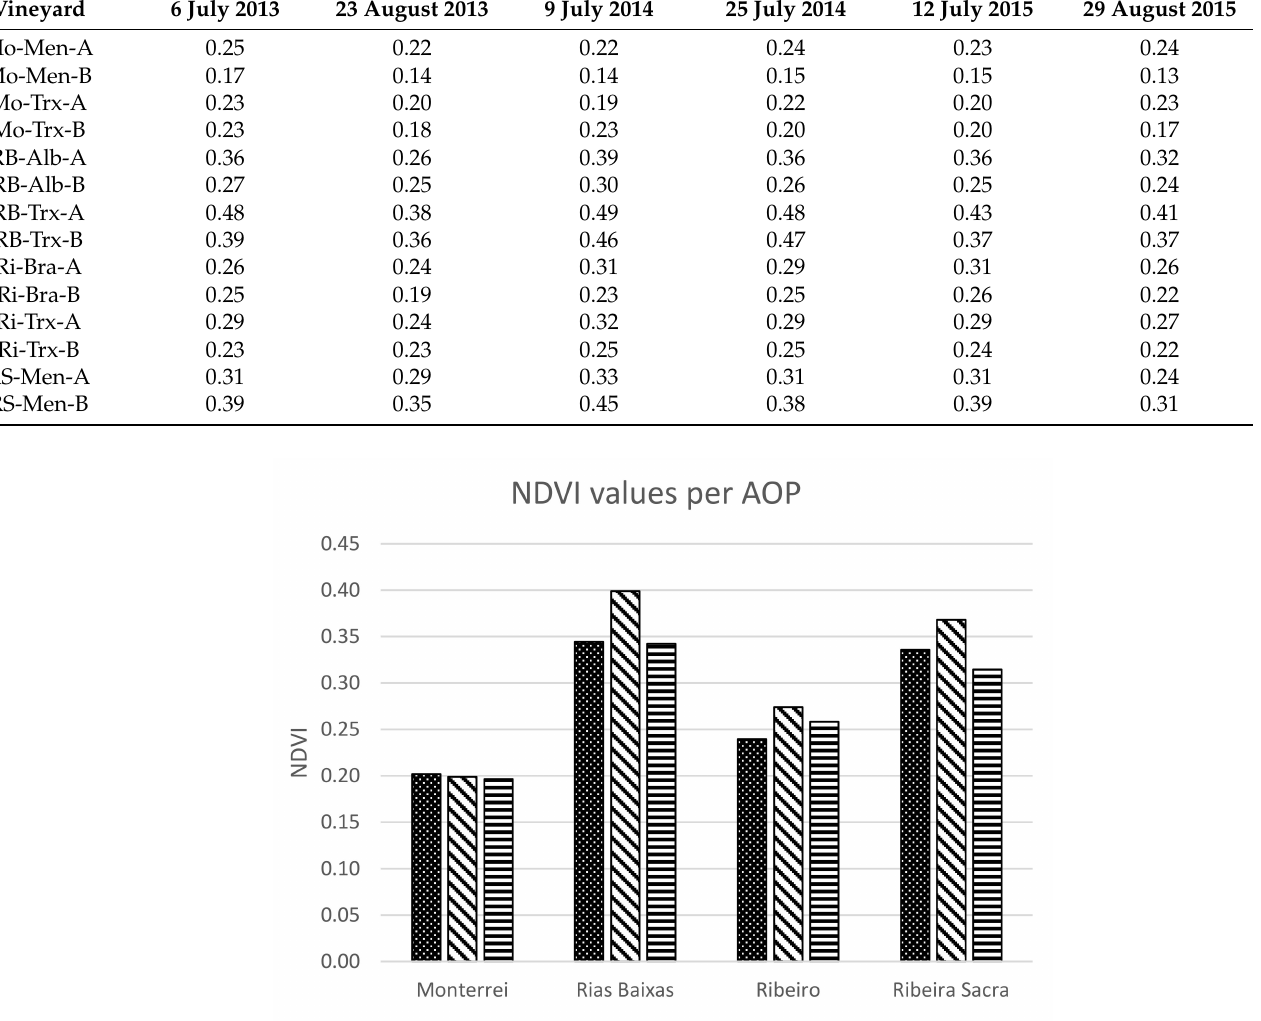
Table 2. NDVI (Normalized Difference Vegetation Index) values calculated using free-cloud Landsat 8 images from the study area taken in 2013, 2014, and 2015. July and August were selected due to the proximity of veraison. Vineyard